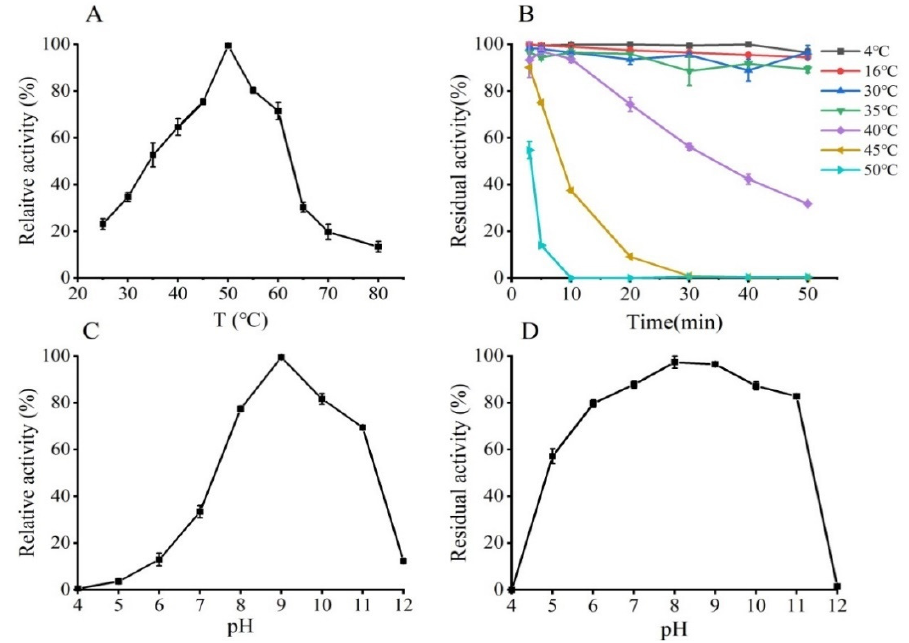
Figure 4. Effects of temperatures ( A , B ) and pHs ( C , D ) on the activity and stability of GmASNase. Data are expressed as mean values ± SD of three independent experiments.